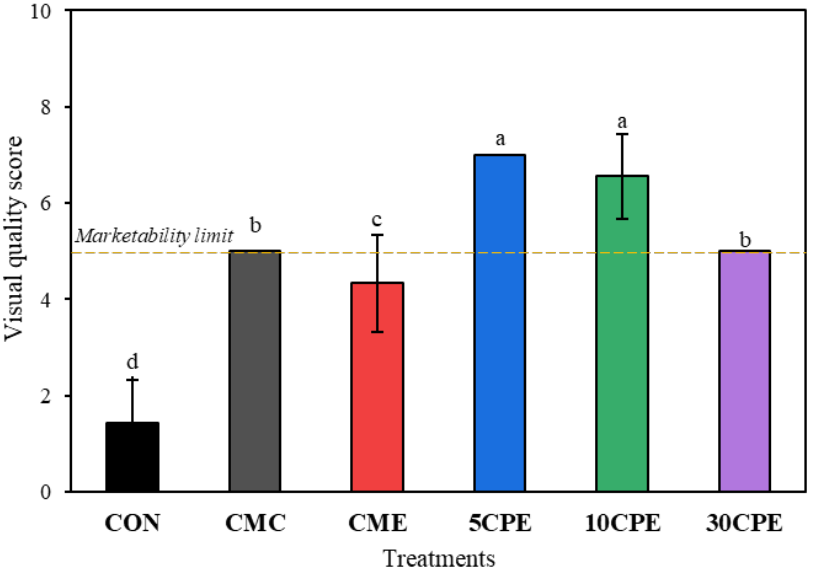
Figure 11. The visual appearance of uncoated and OLP/CMC-coated cherry tomatoes during storage at 30 °C for 14 days. The yellow dashed-line denotes the limit of marketability. Values represent mean ± SD ( n = 15), and different superscripts indicate significant differences (DMRT, p < 0.05).